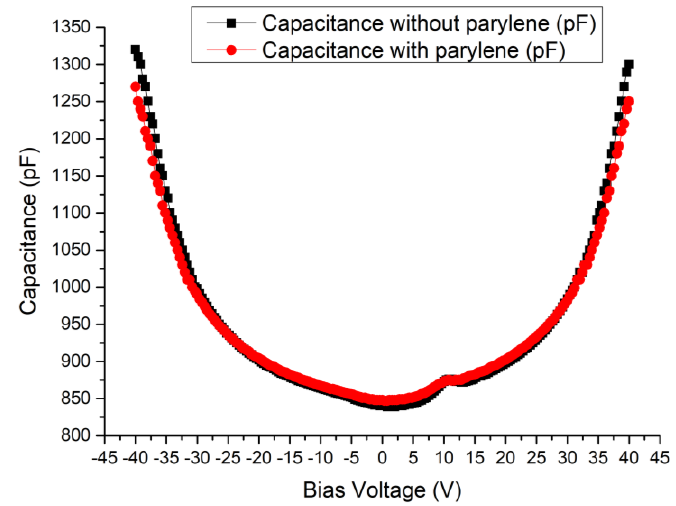
Figure 5. The capacitance-voltage (CV) curves of the CMUT device.